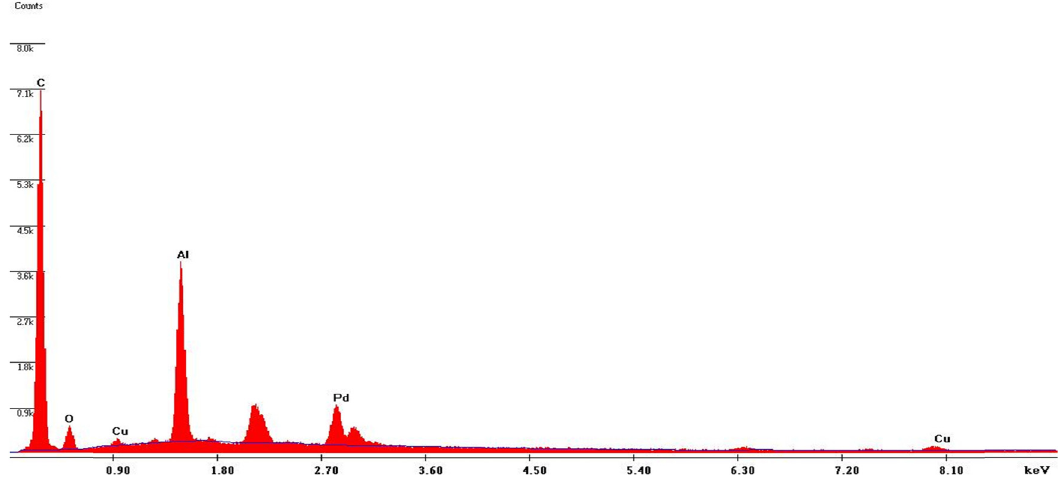
Figure 10: EDX pattern of 4Pd –